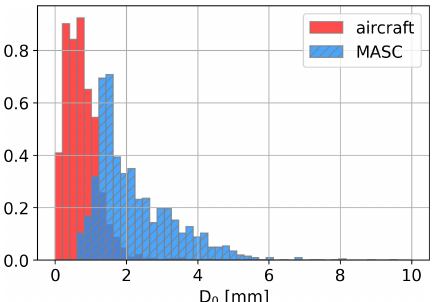
Figure 13. Histogram of D 0 from aircraft measurements (PIP and 2D-S) during ICE GENESIS (red) and from MASC measurements (MASCDB). Figure 14. Colored lines with scattered points: (cid:49) SDFR caused by